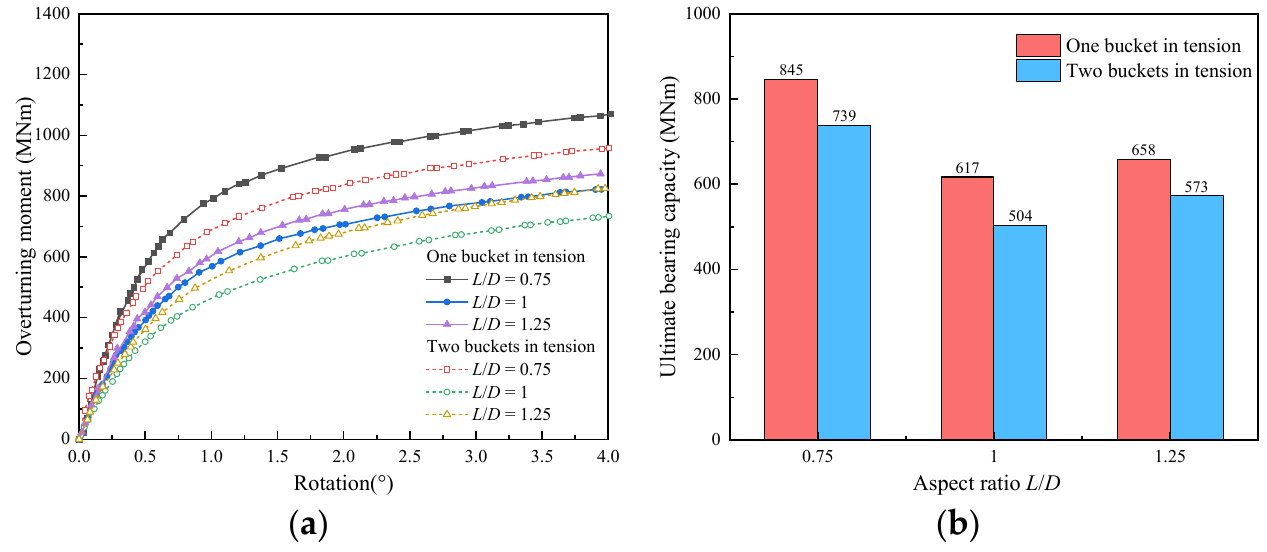
Figure 14. Anti-overturning bearing characteristic in soft clay: ( a ) moment-rotation response, ( b ) ultimate bearing capacity.